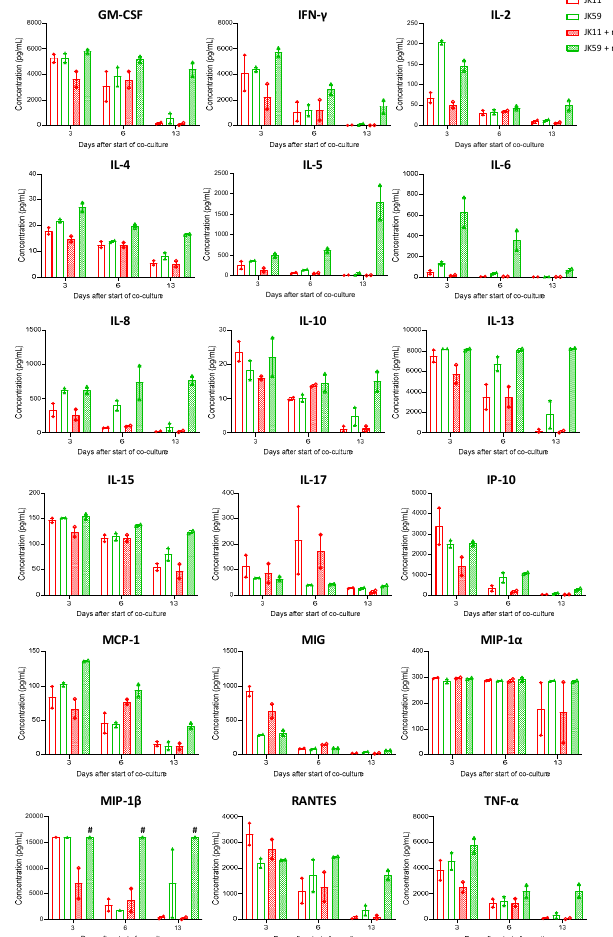
Figure 6. TGF β maintains a high cytokine profile in SwR-STEAP1 CAR T cells after repeated in vitro stimulation of STEAP1 + tumor cells. Luminex cytokine analyses were performed using T cells supernatants isolated at days 3, 6, and 13 from JK11 and JK59 CAR T cells and non-transduced (NT) T cells co-cultured with 22Rv1 target cells in the absence or presence of 10 ng/mL rhTGF β (as shown in Figure 5). Data represent the mean values ± SEM from two healthy donors. Each co-culture from each donor was performed in duplicate, and each duplicate pair was kept separate throughout the experiment. The “#” symbol indicates that the values are higher than 16,000